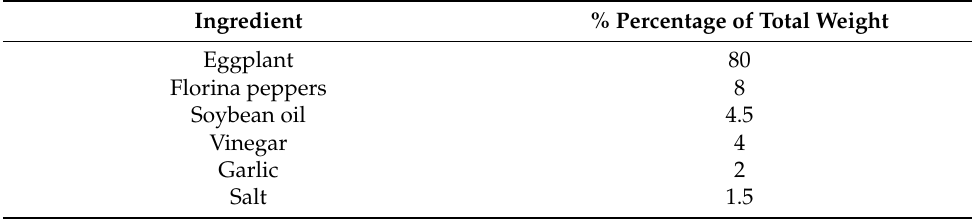
Table 1. % Percentage of ingredients of aubergine salad.